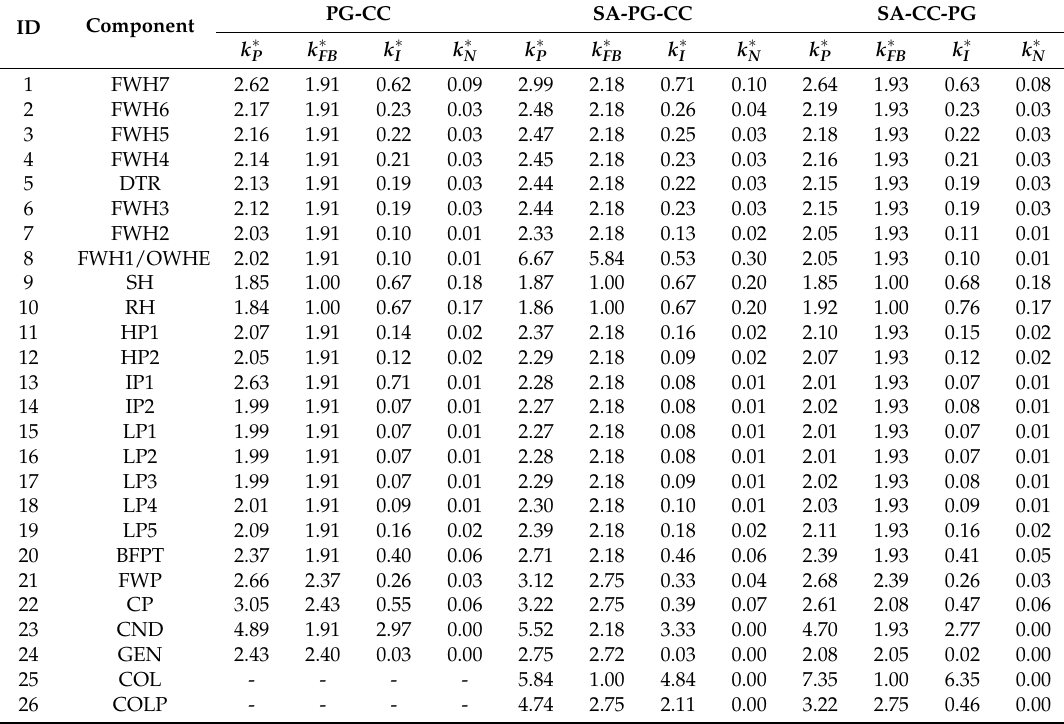
Table A4. Results of Exergy Cost (kW/kW) in the PG-CC, SA-PG-CC and SA-CC-PG